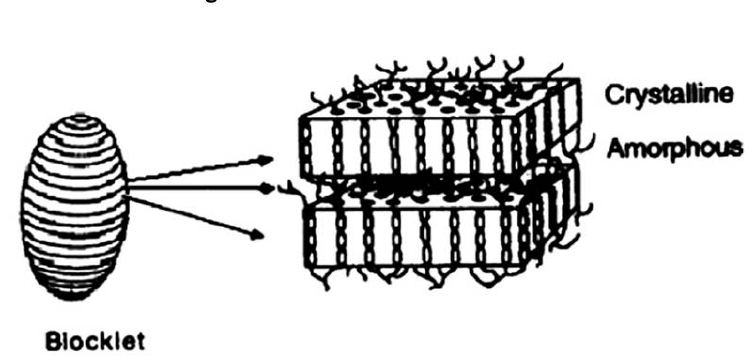
Figure 1. The model of blocklets.